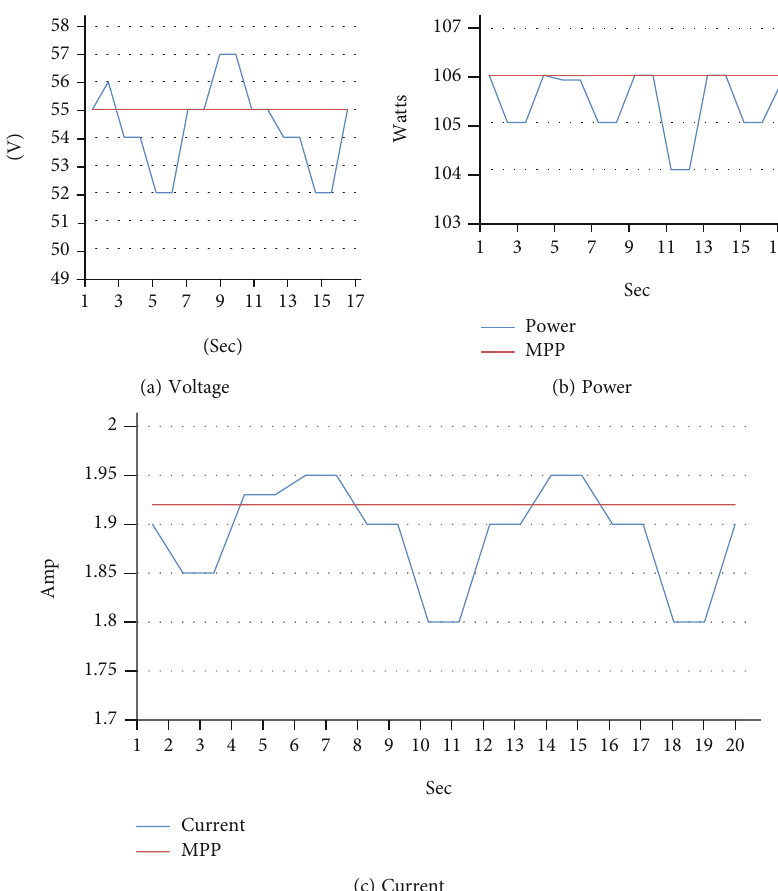
Figure 7: During all the system ’ s operations, MPPT P&O algorithm signals were